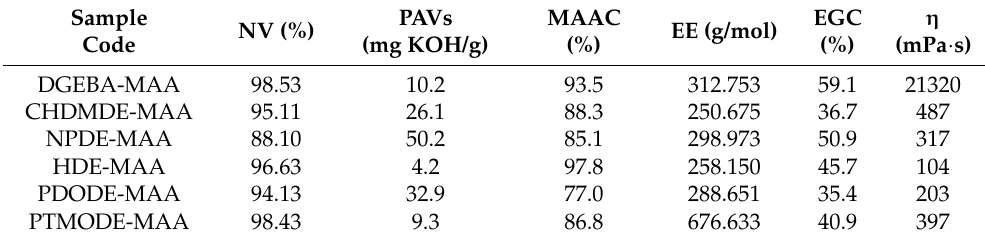
Table 1. Characteristic of manufactured epoxy methacrylate